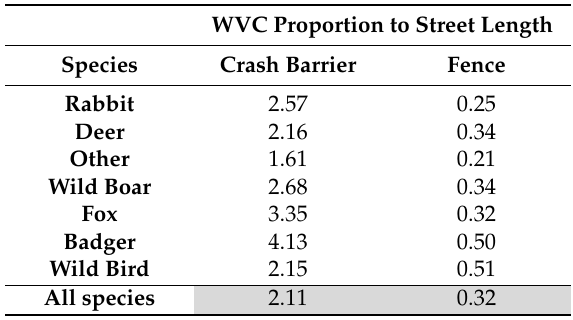
Table 4. WVC per species proportional to street length for road segments with crash barriers and